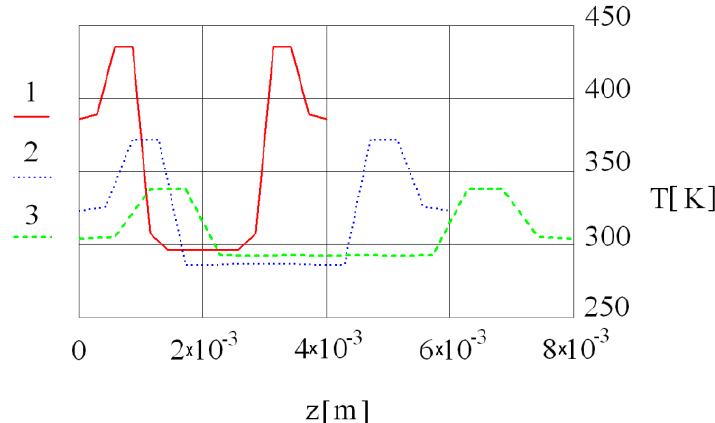
Figure 9. The temperature distribution within the disk gap outlet: 1– h = 4 × 10 − 3 m; 2– h = 6 ·× 10 − 3 m; 3– h = 8 ·× 10 − 3 m.